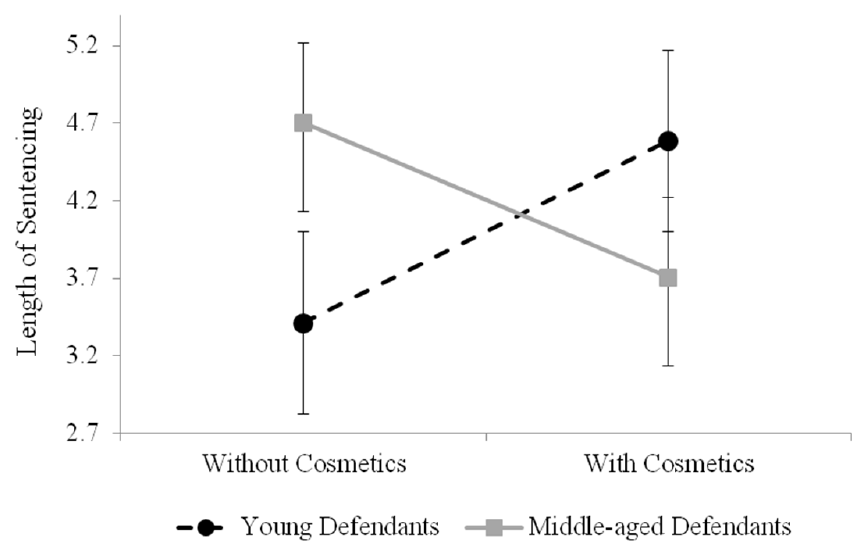
Figure 2. Sentences given to young defendants (dashed line, filled circles) compared to sentences given to middle-aged defendants (solid line, filled squares) by male participants. Standard error bars are displayed.